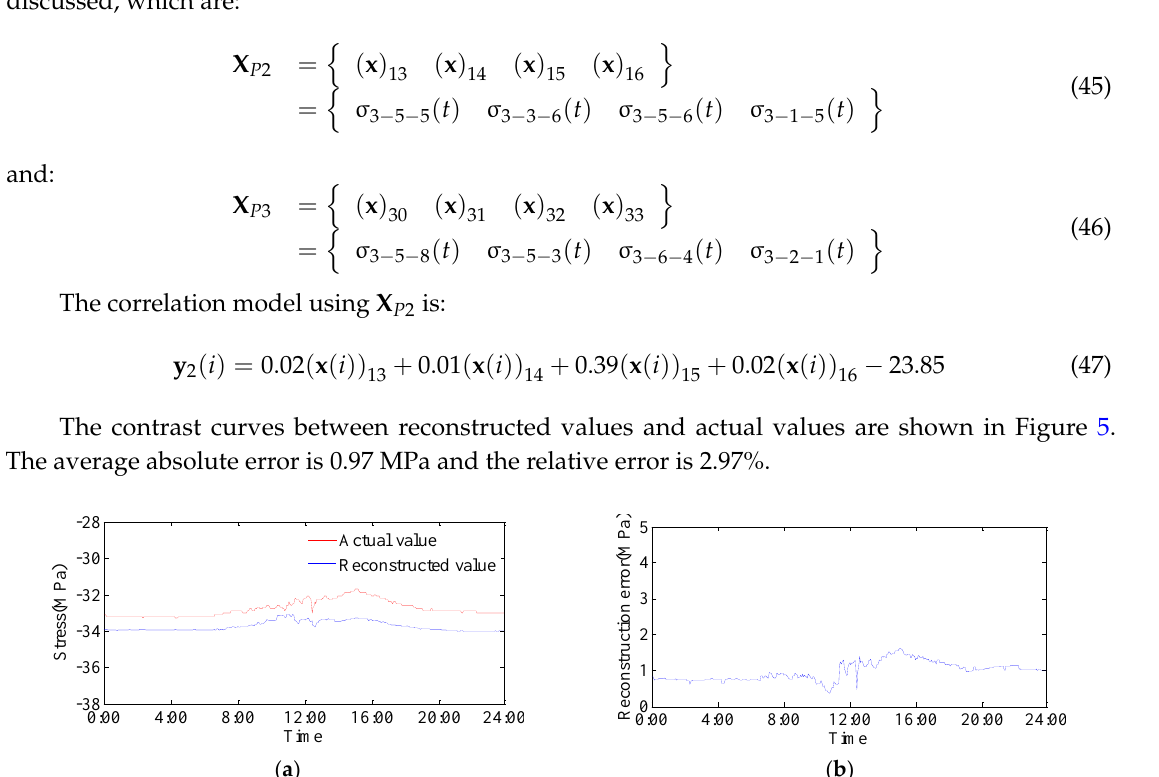
Figure 5. The reconstructed value and the actual value using response variable X P 2 : ( a ) the curve of the reconstructed value and the actual value; and ( b ) the curve of reconstruction error.